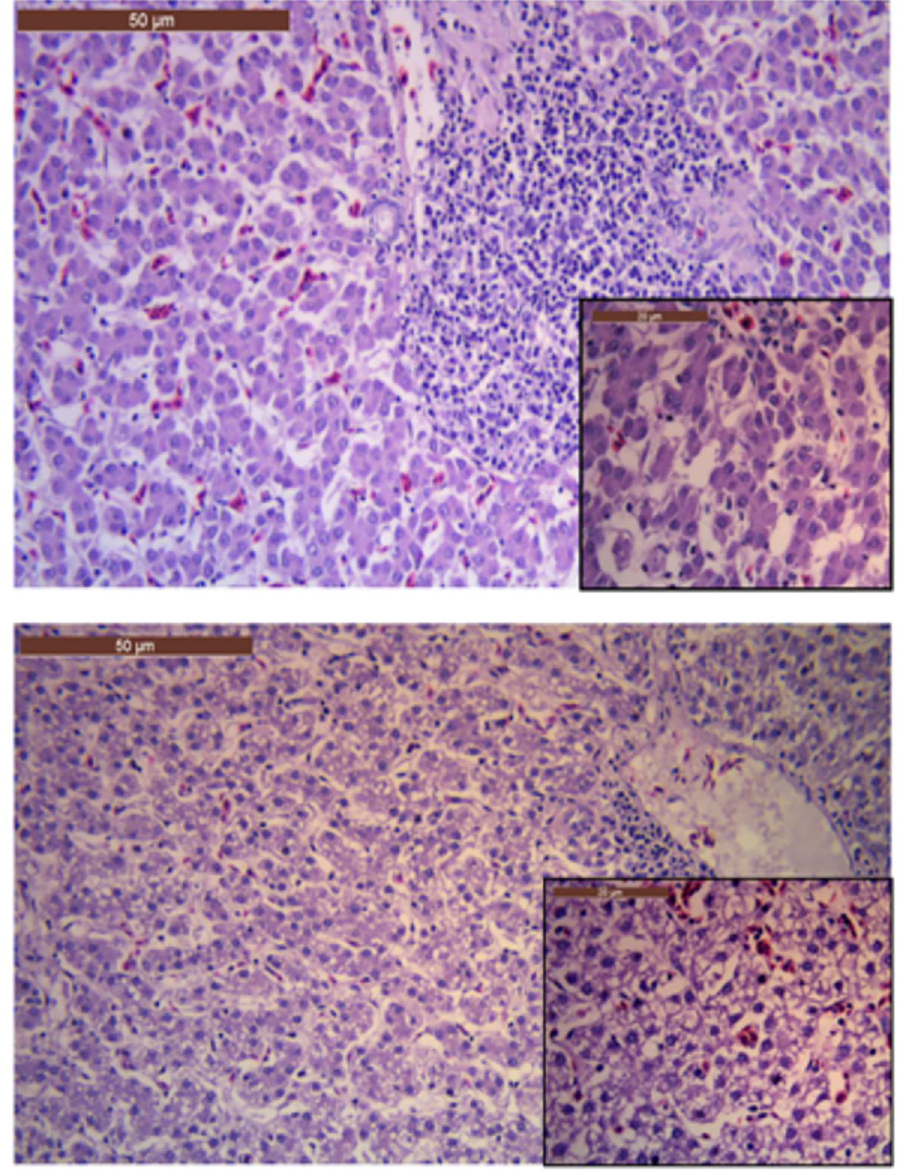
Fig 3. Liver histology. a) Liver section from a chicken in the control group (not receivingany treatment after challenge with E . coli APEC_O2). Notice the normal and regular hepatocytes; b) Liver section from a chicken in the sertraline-treatedgroup. Notice the major vacuolization of the hepatocytes. Each of the large images is at 20X magnification, insert in the corners are from the same image, but at 40X